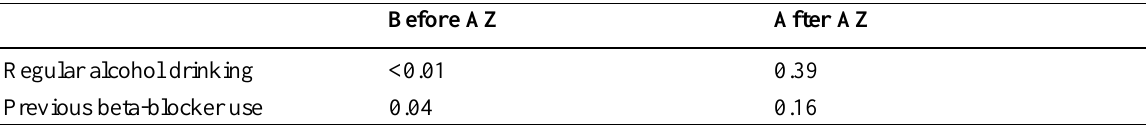
Table 2. Determinants of age-related increase in ME-Dif before and after AZ treatment